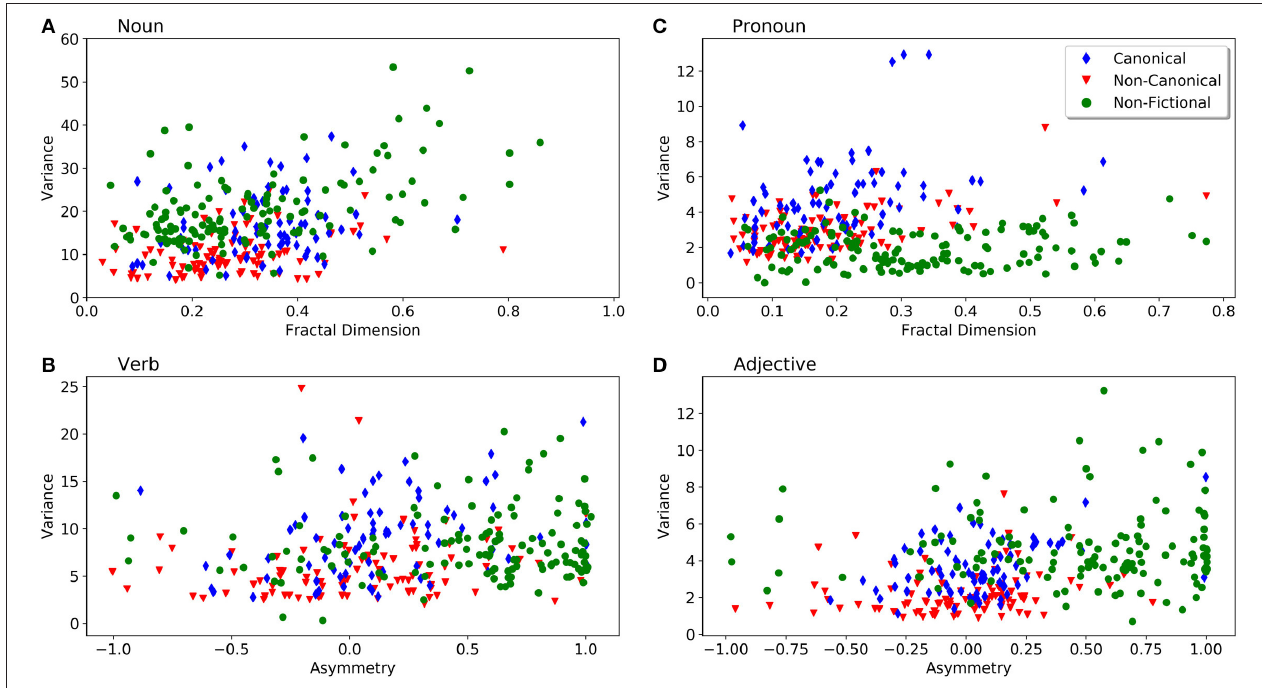
FIGURE 6 | Scatter plots of variance (y-axis) and fractal features of POS-tags (x-axis). (A) Degree of fractality ( H ) and the variance of noun series. (B) Degree of multifractality ( D ) and the variance of verb series. (C) Degree of multifractality ( D ) and the variance of pronoun series. (D) Fractal asymmetry ( A ) and the variance of adjective series. Each dot represents one text from our corpus. For color coding of the text categories, see insert in (B)